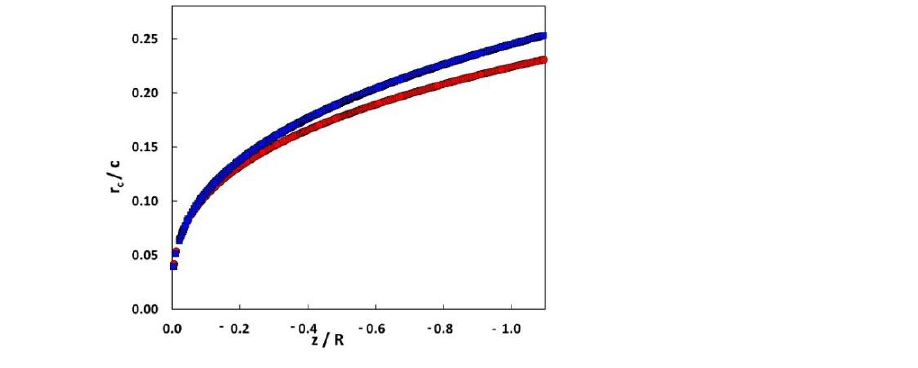
Figure 12. BEM (blue) and Experimental (red) normalised core radius versus the distance from the rotor disk.